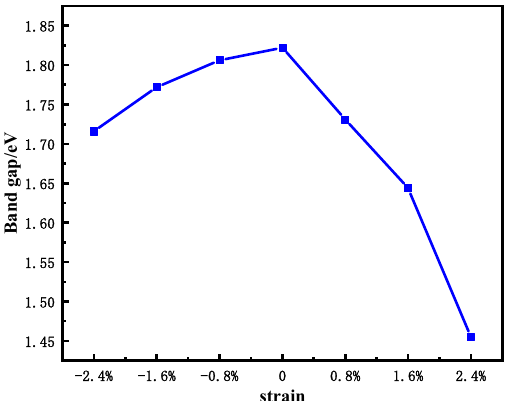
Figure 3. Band gap change of single-layer MoS 2 under different strains.